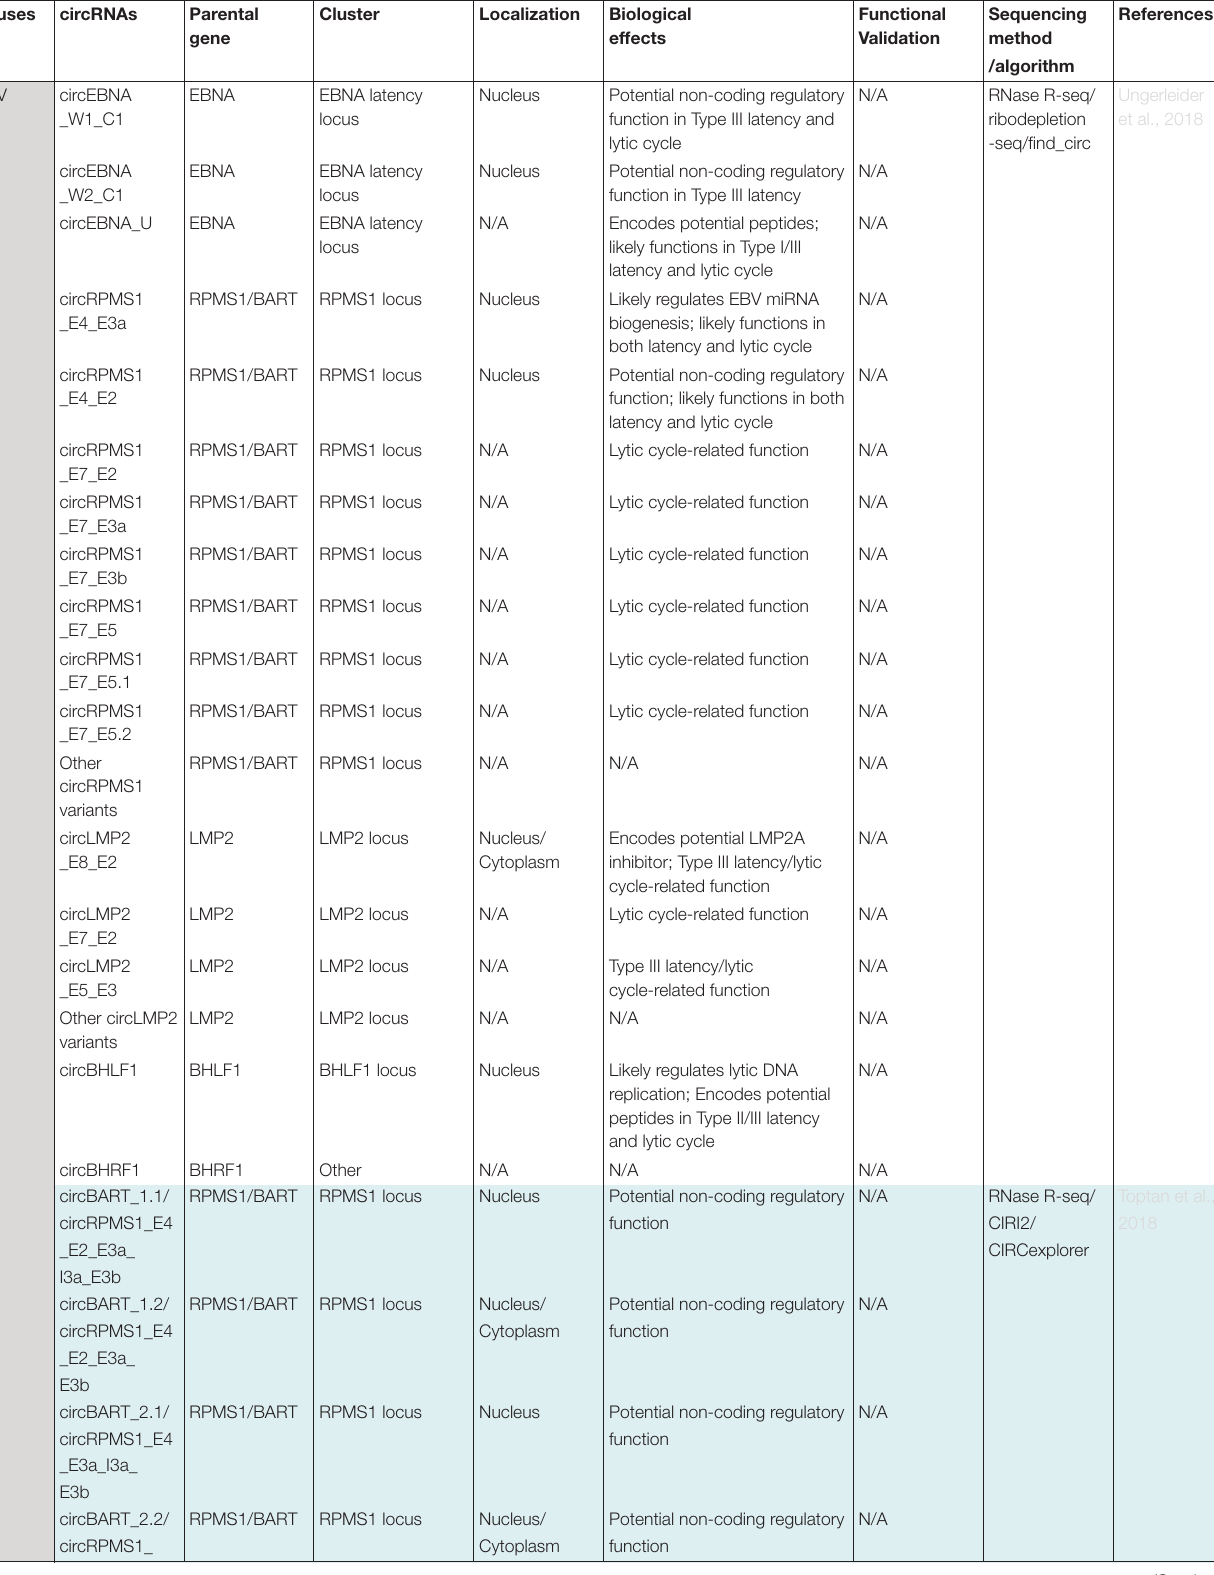
TABLE 2 | Summary of currently identified circRNAs encoded by human oncogenic viruses and their biological effects. Viruses